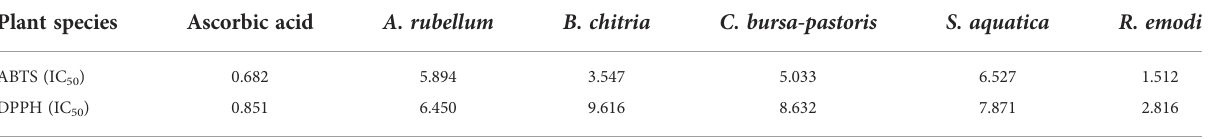
TABLE 4 IC 50 (µg/ml) of antioxidant assay of ABTS and DPPH in the collected wild edible plants. Plant species